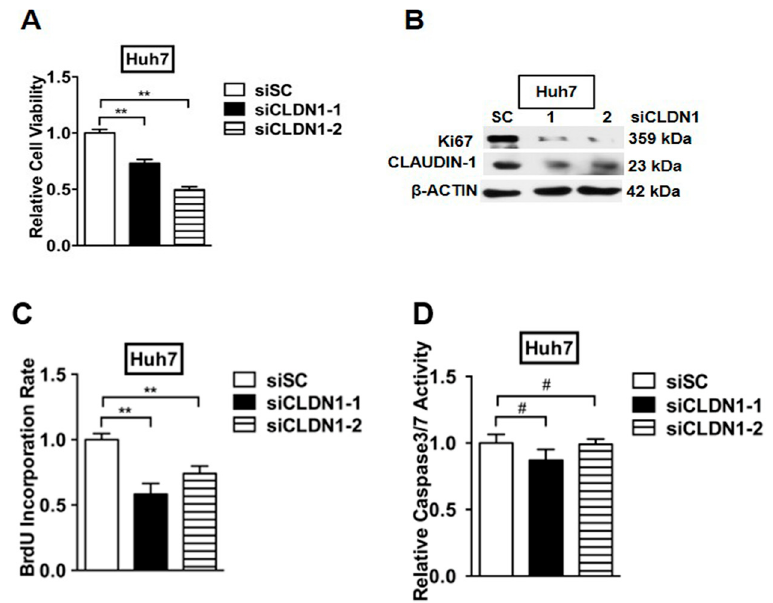
Figure 8. CLAUDIN-1 depletion decreases cell proliferation of HCC cells without modulating cell survival. ( A ) Cell viability of Huh7 cells with CLAUDIN-1 depletion. The Huh7 cells were transfected with CLAUDIN-1 specific siRNAs or scrambled siRNAs. After 48 h, cell viability was determined by MTT assay. ** p < 0.01; ( B ) Western blot analysis for Ki67, a cell proliferating marker in Huh7 cells transfected with CLAUDIN-1 specific siRNAs or scrambled siRNAs; ( C ) Cell cycle progression of Huh7 cells transfected with CLAUDIN-1 specific siRNAs or scrambled siRNAs was assessed by BrdU incorporation. ** p < 0.01; ( D ) Huh7 cells were transfected with CLAUDIN-1 specific siRNAs or scrambled siRNAs for 24 h, and cell apoptosis was subsequently assessed by measuring caspase 3/7 activity. # no statistical significance.